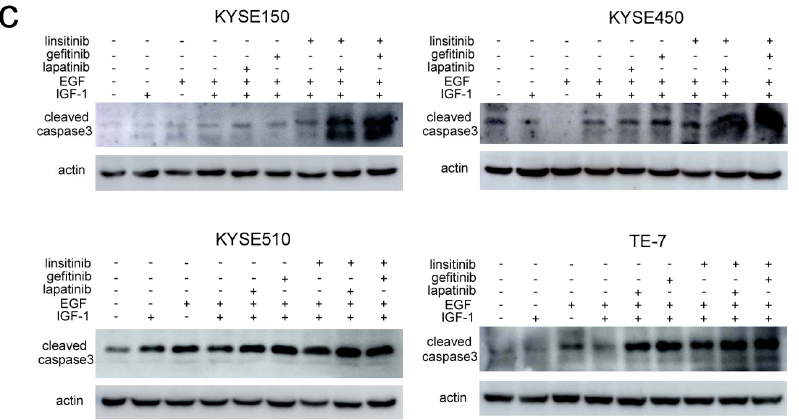
3 Figure 2. The effects of lapatinib, gefitinib, and linsitinib alone or in combination on the cell cycle distribution and cell apoptosis. ( a ) Four ESCC cells were stained with propidium iodide (PI) after treatment by lapatinib, gefitinib, linsitinib, lapatinib+linsitinib, and gefitinib+linsitinib for 48 h. The fluorescence intensity was measured by a flow cytometer, and the cells distributed in the G1, S, and G2/M phases were analyzed by ModiFit software. ** p < 0.01, *** p < 0.001, the ratio of G1 phase cells in the drug treatment group vs. the control group. # p < 0.05, ### p < 0.001, comparison of the G1 phase ratios between the depicted groups, respectively. ( b ) ESCC cells were exposed to single drugs or in combinations, as indicated, and then the apoptotic cells were stained with Annexin V-FITC and PI. The fluorescence intensity was measured by a flow cytometer. ns, not significant, * p < 0.05, ** p < 0.01, *** p < 0.001 vs. control. ## p < 0.01, ### p < 0.001, between the depicted groups, respectively. ( c ) Western blot analysis of the expression of cleaved caspase-3 in ESCC cells after treatment with lapatinib, gefitinib, and linsitinib alone or in combination. Actin was used as the loading control. 3.